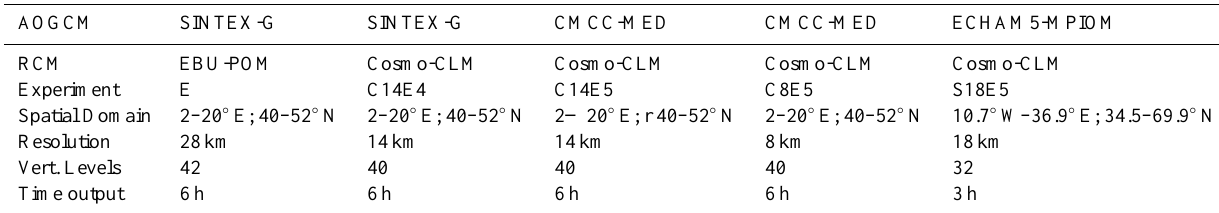
Table 1. Summary table of the five analyzed RCM